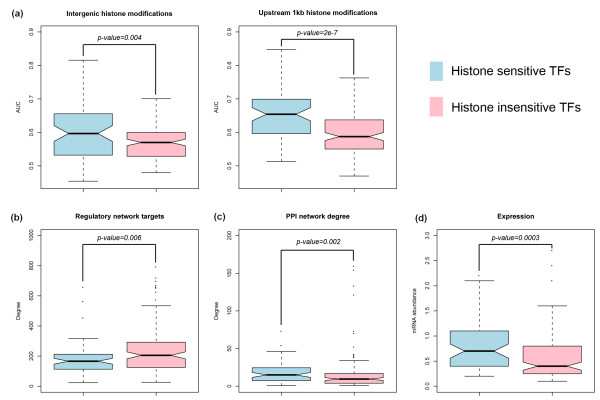
Distinctions between histone-sensitive and -insensitive TFs. (a) Target genes of histone-sensitive TFs are better predicted using intergenic or upstream histone modifications than are those of histone-insensitive TFs. (b) Histone-sensitive TFs have a smaller number of target genes in the regulatory network than histone-insensitive TFs. (c) Histone-sensitive TFs have a larger number of interaction partners in the protein-protein interaction (PPI) network. (d) Higher mRNA expression levels of histone-sensitive TFs.